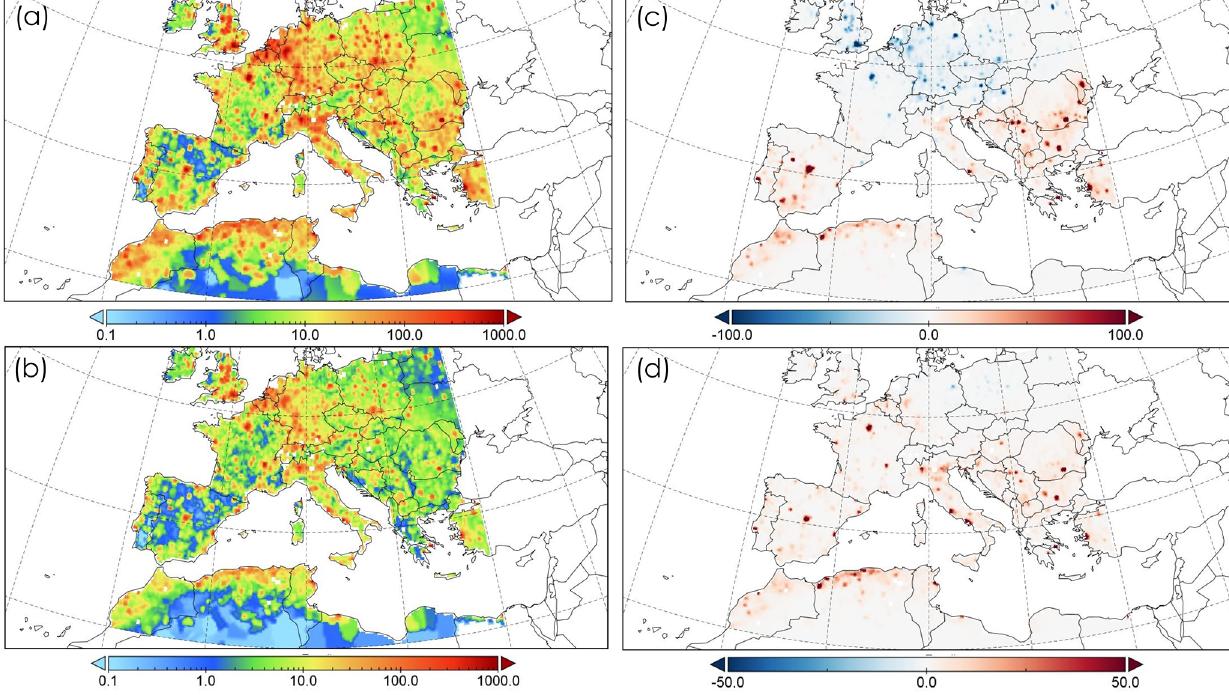
Figure 7. (a) Present cases of premature deaths (PD) and (b) associated costs, in millions of euros. (c) Changes projected in PD and (d) changes in costs (millions of euros) under the RCP8.5 scenario